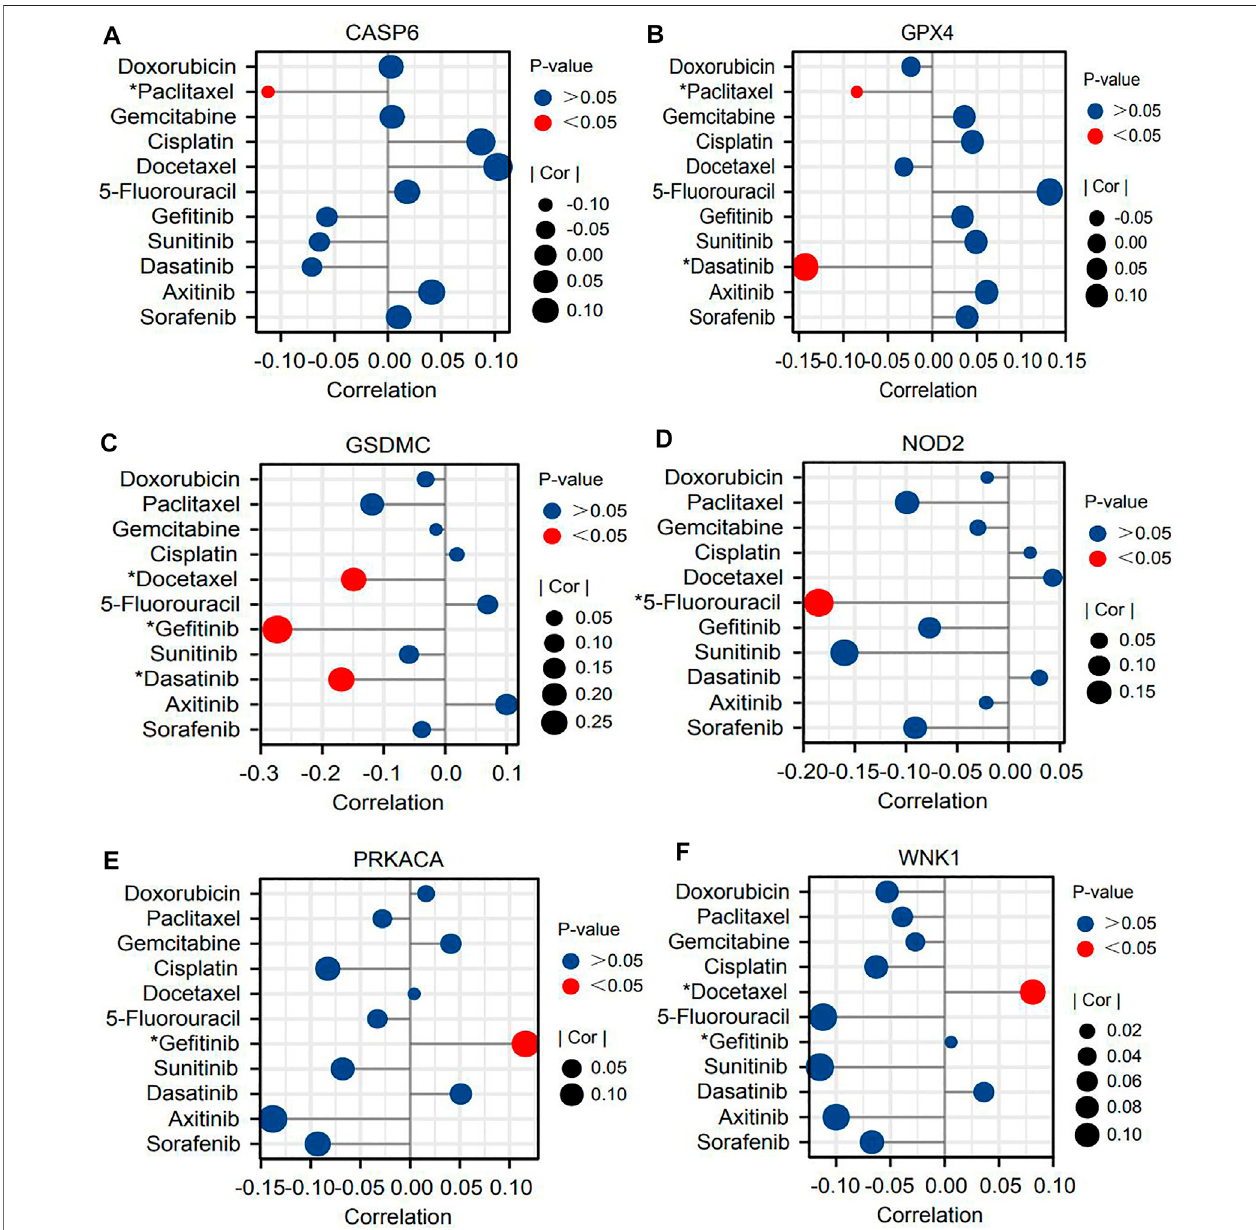
FIGURE7| SixcorePRGsmayaffectthesensitivitiesofmultiplemoleculartargetdrugsandchemotherapydrugsbasedontheGSDCdatabase. (A – F) Thecorrelations between the expressions of six PRGs and IC50 values of eleven drugs. PRGs, pyroptosis-related genes; IC50, half-maximal inhibitory concentration; * p < 0.05.